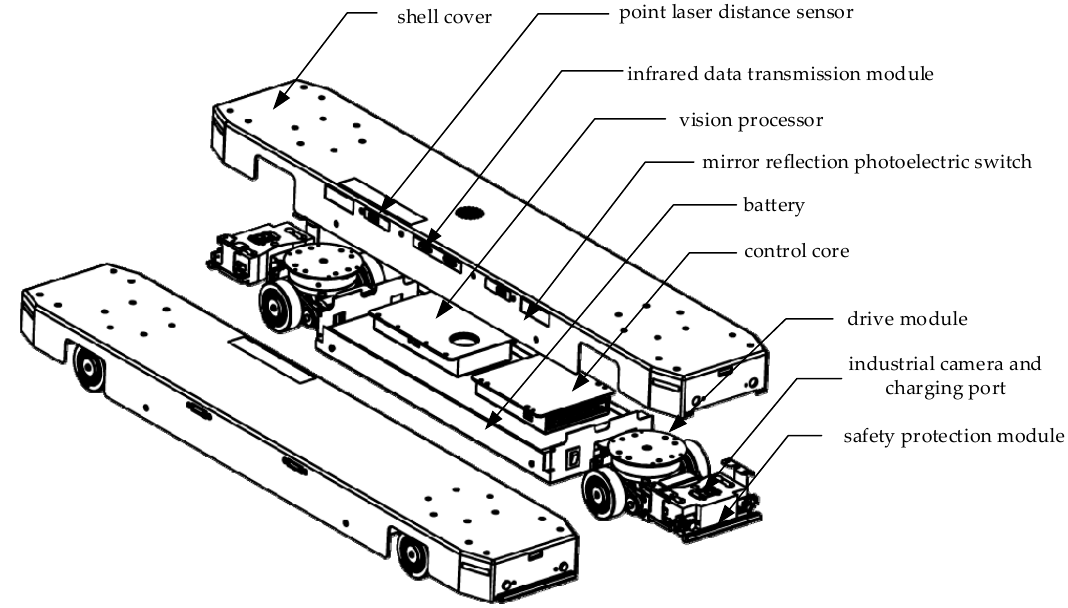
Figure 3. Schematic diagram of separate parallel intelligent mobile robot.